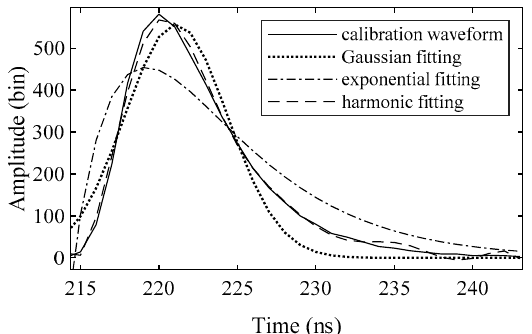
Figure 9. Calibration waveform (solid) and fitting curves (dashed) with Gaussian, exponential and harmonic models. The Gaussian model includes only one Gaussian function. The exponential model is a sum of two exponential functions, and the harmonic model is a combination of four harmonic functions. All fitting parameters were solved by a Levenberg–Marquardt algorithm, and the adjusted R-Square (R 2 ) coefficients of Gaussian, exponential and harmonic models are 0.9332, 0.8015 and 0.9956 respectively.